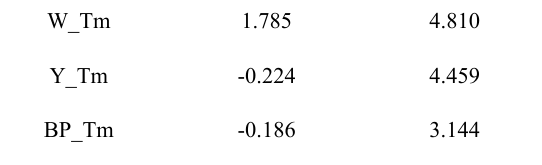
Table 1. Accuracy statistical analysis of different models